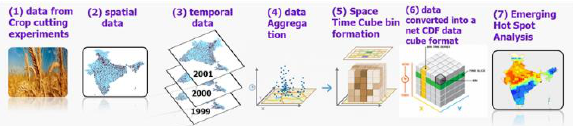
Figure 1. Workflow for data processing and analysis